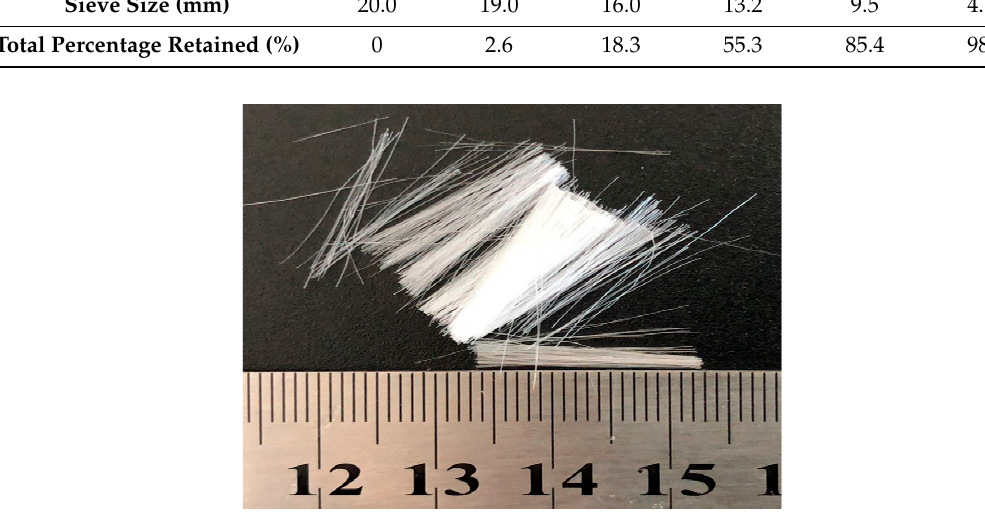
Table 3. The gradation compositions of the coarse aggregate. Table 1. Chemical compositions of cement .